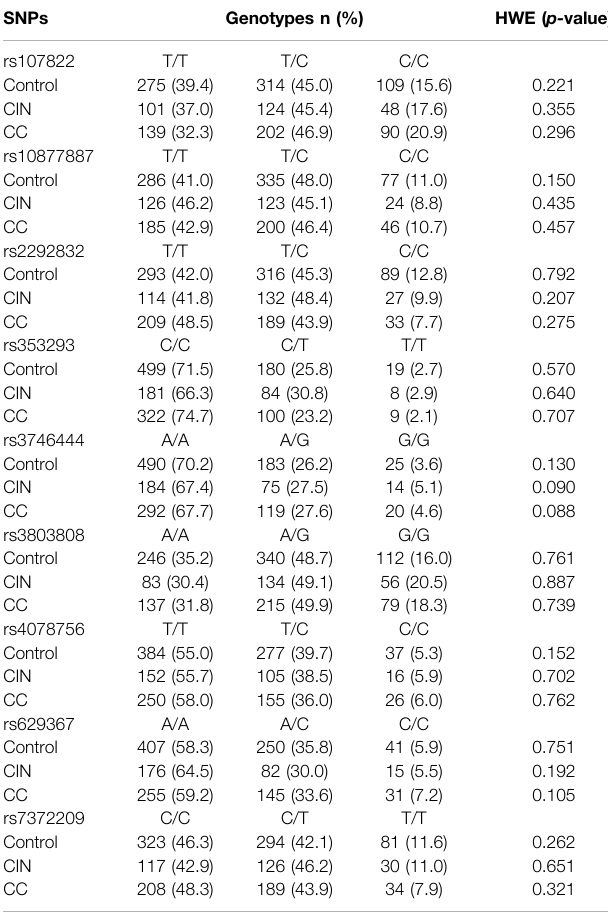
TABLE 3 | The Hardy – Weinberg equilibrium signi fi cance tests of the nine miRNA SNPs selected in the current study. SNPs Genotypes n